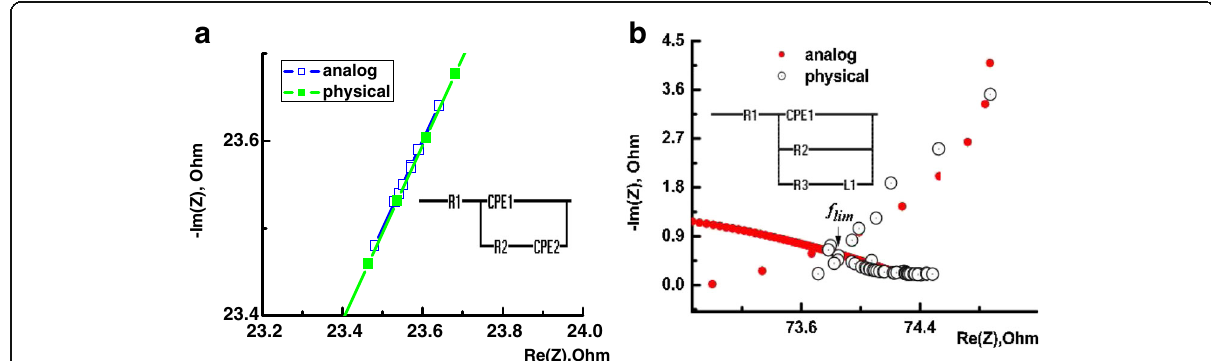
Fig. 3 Impedance spectra (Nyquist plots) for MCT samples implanted with B + ( a ) and Ag + ( b ) ions. Inset shows the equivalent circuit